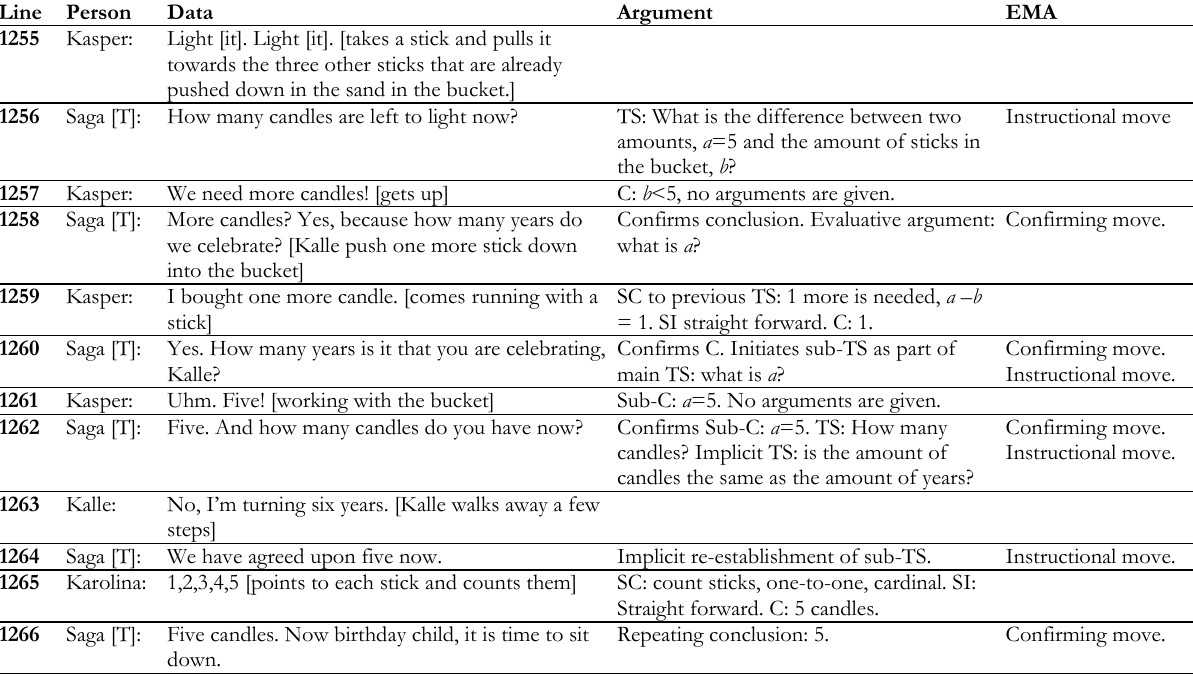
Table 3. Initiation of evaluative